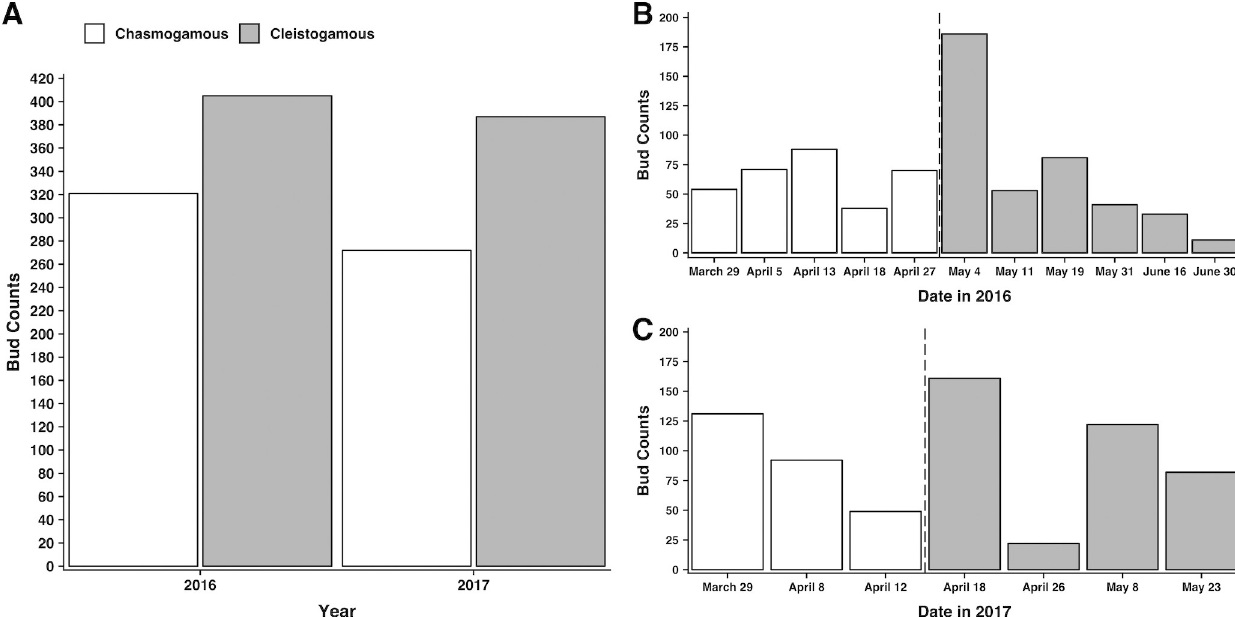
Fig 2. Total number of chasmogamous (white bars) and cleistogamous (gray bars) buds recorded from ten plots in A) 2016 and 2017 and at each measurement date in B) 2016 and C) 2017. Dashed vertical lines highlight bud type transition, the time at which chasmogamous budding ceased and the first cleistogamous buds were